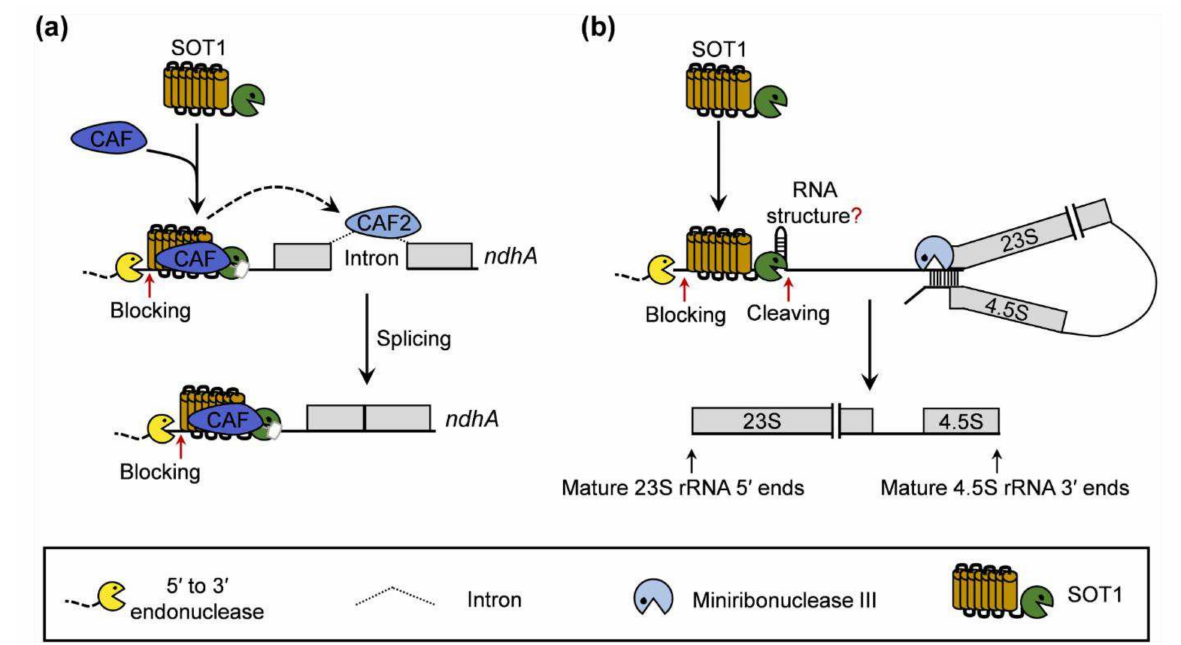
Figure 10. Proposed model for the role of SOT1 in RNA metabolism in the chloroplasts. ( a ) SOT1 functions together with the CAF proteins (CAF1 or CAF2) and forms an interaction complex that synergistically promotes SOT1 binding to the 5 (cid:48) ends of ndhA transcripts, thereby blocking the 5 (cid:48) to 3 (cid:48) exonuclease invasion. The CAF proteins are capable of inhibiting the RNA endonuclease activity of the SOT1 SMR domain, which facilitates the stabilizing effect of SOT1 on the ndhA transcripts. In addition, SOT1 helps promote the splicing of the ndhA precursor by facilitating the association of CAF2 with the ndhA intron region. Red arrows indicate the blocking sites for exonucleases. ( b ) Without interacting with the CAF proteins, SOT1 directly binds to the 5 (cid:48) ends of the chloroplast 23S − 4.5S rRNA precursor via its PPR motifs, which block 5 (cid:48) to 3 (cid:48) exonuclease invasion. The C-terminal SMR domain of SOT1 cleaves the rRNA precursor at the − 38 nt site relative to the 5 (cid:48) end of mature 23S rRNA. SOT1 also facilitates the processing by miniribonuclease III during the maturation of 23S and 4.5S rRNA [13,22,23]. Red arrows indicate the blocking sites for exonucleases and cleaving site of SOT1, respectively. The question mark indicates that the RNA structure formed around the SOT1 cleaving site is